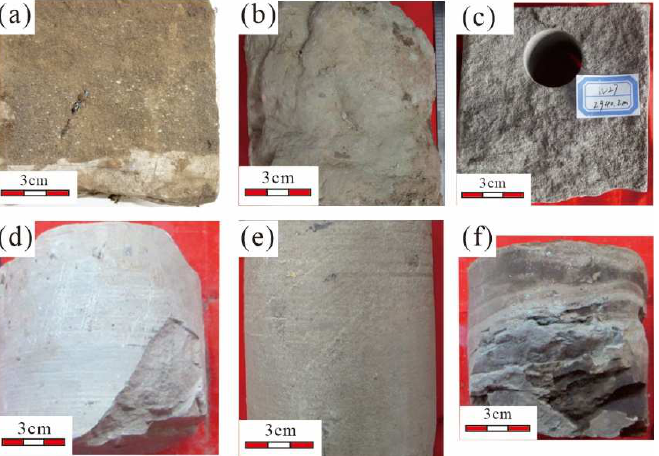
Figure 3. Core photos of Ek1 member in the Wang Guantun Area. ( a ) pebbly sandstone; ( b ) coarse sandstone; ( c ) medium fine sandstone; ( d ) siltstone; ( e ) argillaceous siltstone; ( f ) mudstone.